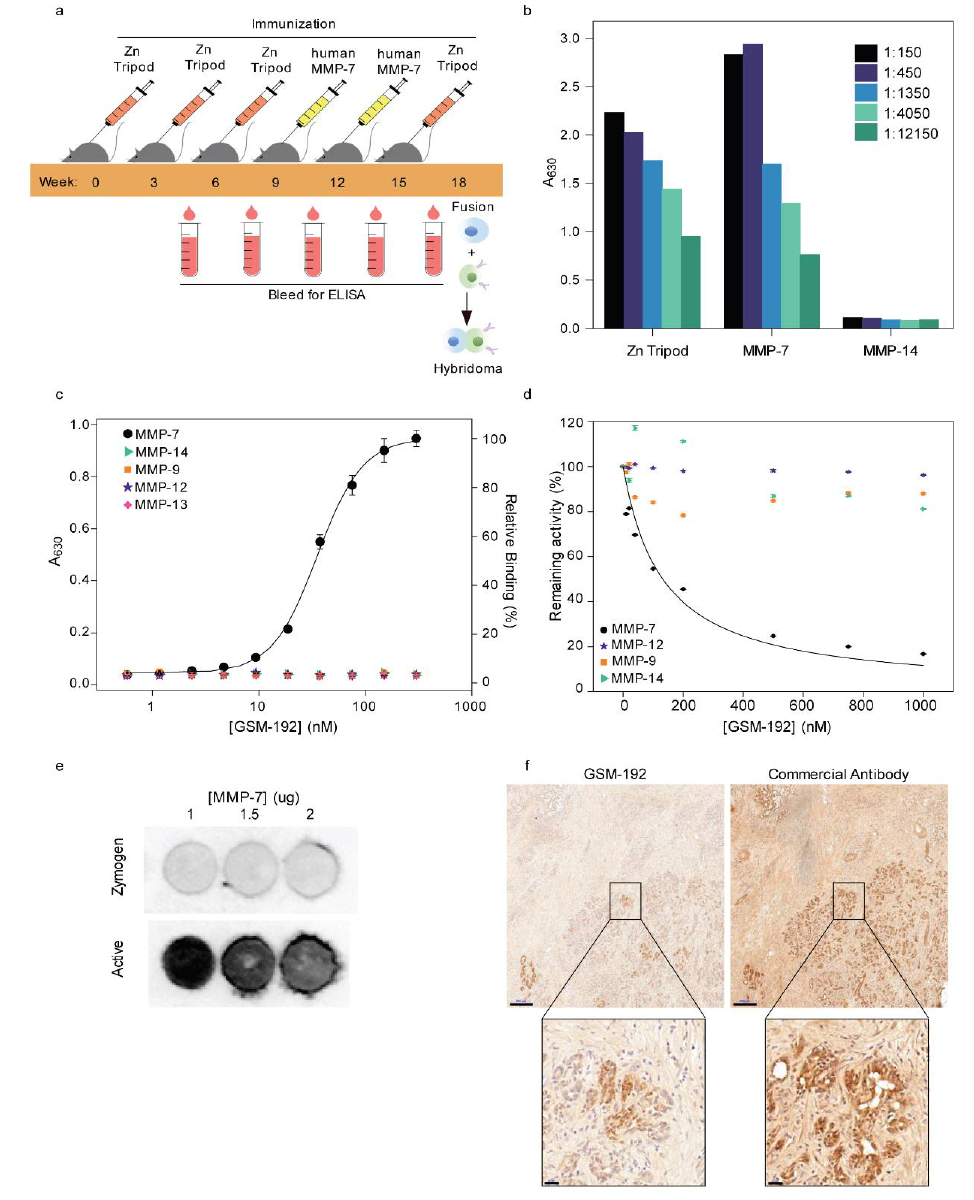
Figure 1. Sequential immunization yields anti MMP-7 antibody with high binding affinity and selectivity. ( a ) Female BALB/c mice were immunized in 3-week intervals with synthetic Zinc-Tripod-KLH (Zn Tripod) emulsified with complete Freund’s adjuvant or recombinant human MMP-7. Progressive immune responses were observed as a function of repeti- tive injection using an ELISA. B-cells from candidates with high binding affinity were selected for hybridoma generation at week 18. ( b ) Serum immune response of selected mouse prior to fusion against Zn-Tripod, MMP-7 and negative control MMP-14, showed bi-specificity towards both Zn Tripod and MMP-7 when examined using ELISA, and exhibited negligi- ble binding with MMP-14 at various dilutions. ( c ) Purified hybridoma monoclonal antibody GSM-192 binding curve with MMP-7 active enzyme (EC 50 = 43 ± 1 nM). The antibody did not bind effectively to a panel of other MMPs indicating its high specificity towards MMP-7. ( d ) The effect of GSM-192 Fab on the enzymatic activity of human MMP-7 was examined in vitro , using short fluorogenic peptides. GSM-192 Fab inhibited MMP-7 activity at IC 50 = 132 ± 10 nM. Related